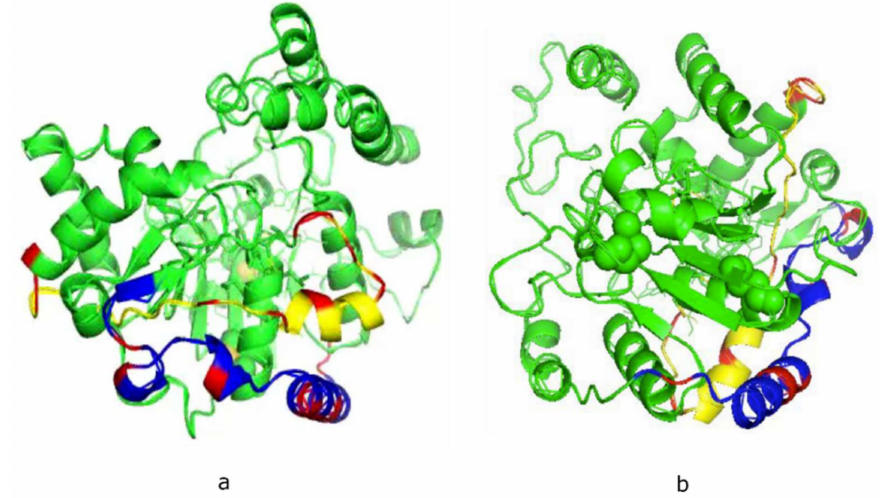
Figure 1. Theoretical models of human ST8Sia II ( a ) and ST8Sia IV ( b ) developed using the Phyre2 server. The basic residues in polysialyltransferase domain (PSTD, yellow) and polybasic region (PBR, blue) are labeled in red. The shortest distance between PBR and PSTD is 4–5